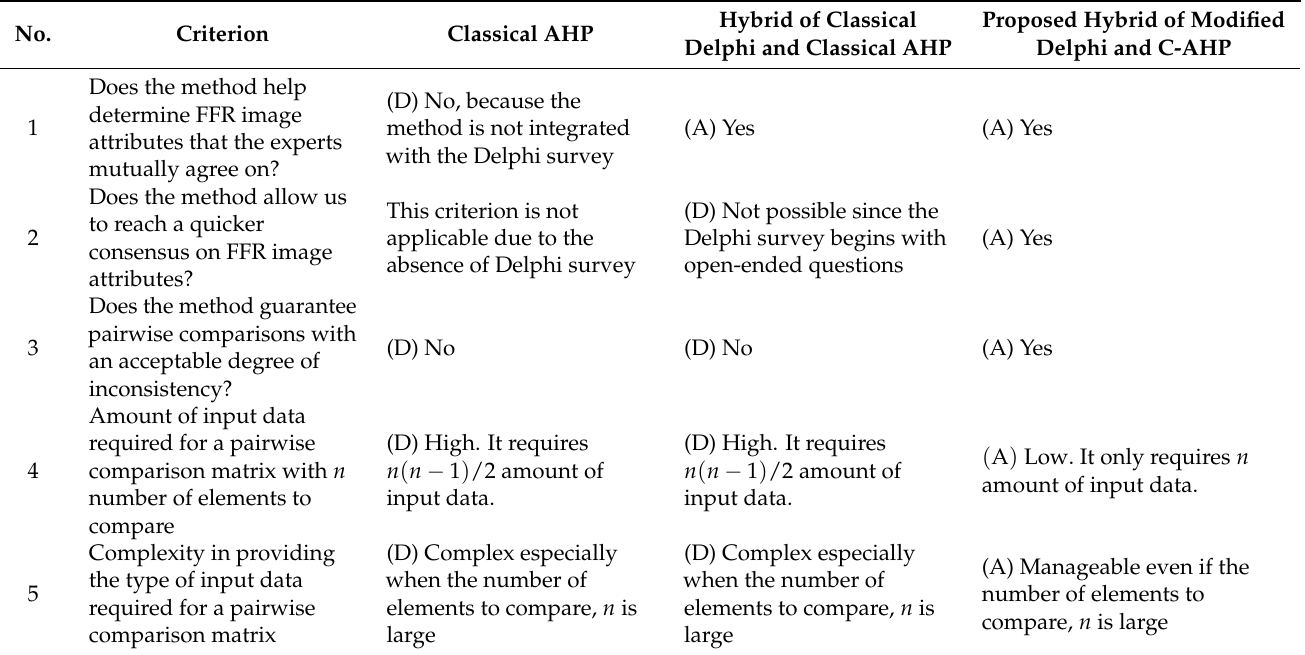
Table 3. Comparison between